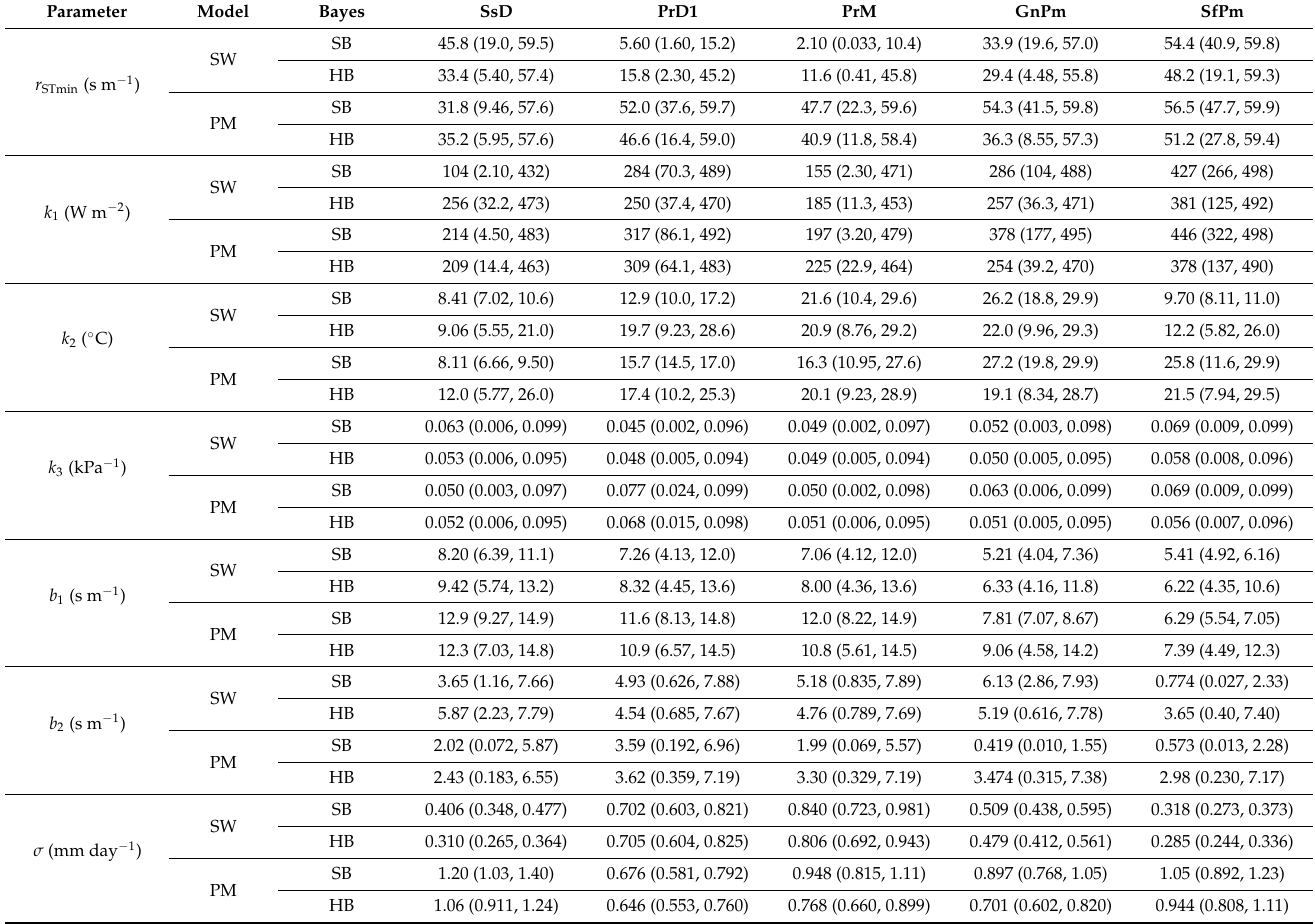
Table A1. Posterior probability distributions of the parameters in the Shuttleworth–Wallace (SW) and the Penman–Monteith (PM) models using simple Bayesian (SB) and hierarchical Bayesian (HB) approaches for five observations, characterized by the posterior means and 95% Bayesian confidence